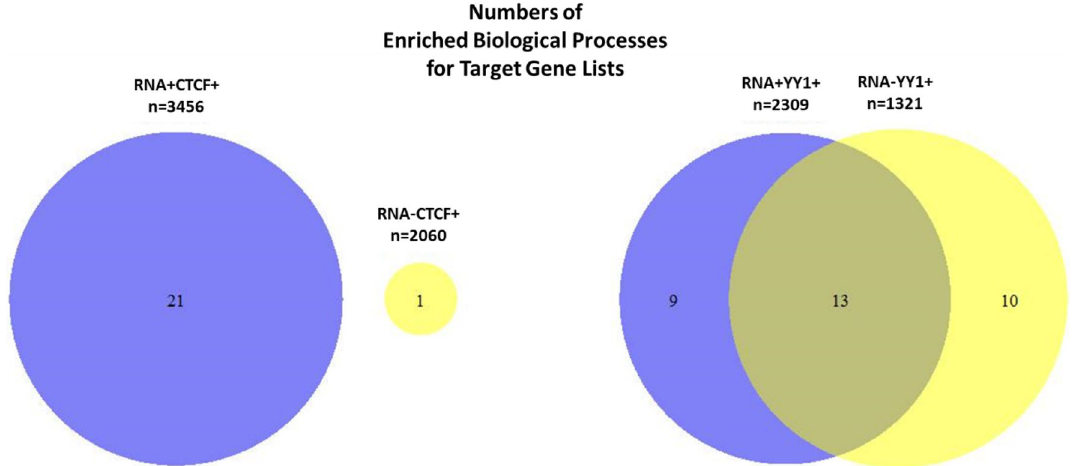
Figure 3. Numbers of biological processes (g:Profiler) that were significantly overrepresented (adjusted p < 0.01) in unique lists of genes interacting with RNA-PIRs or nonRNA-PIRs containing CTCF or YY1